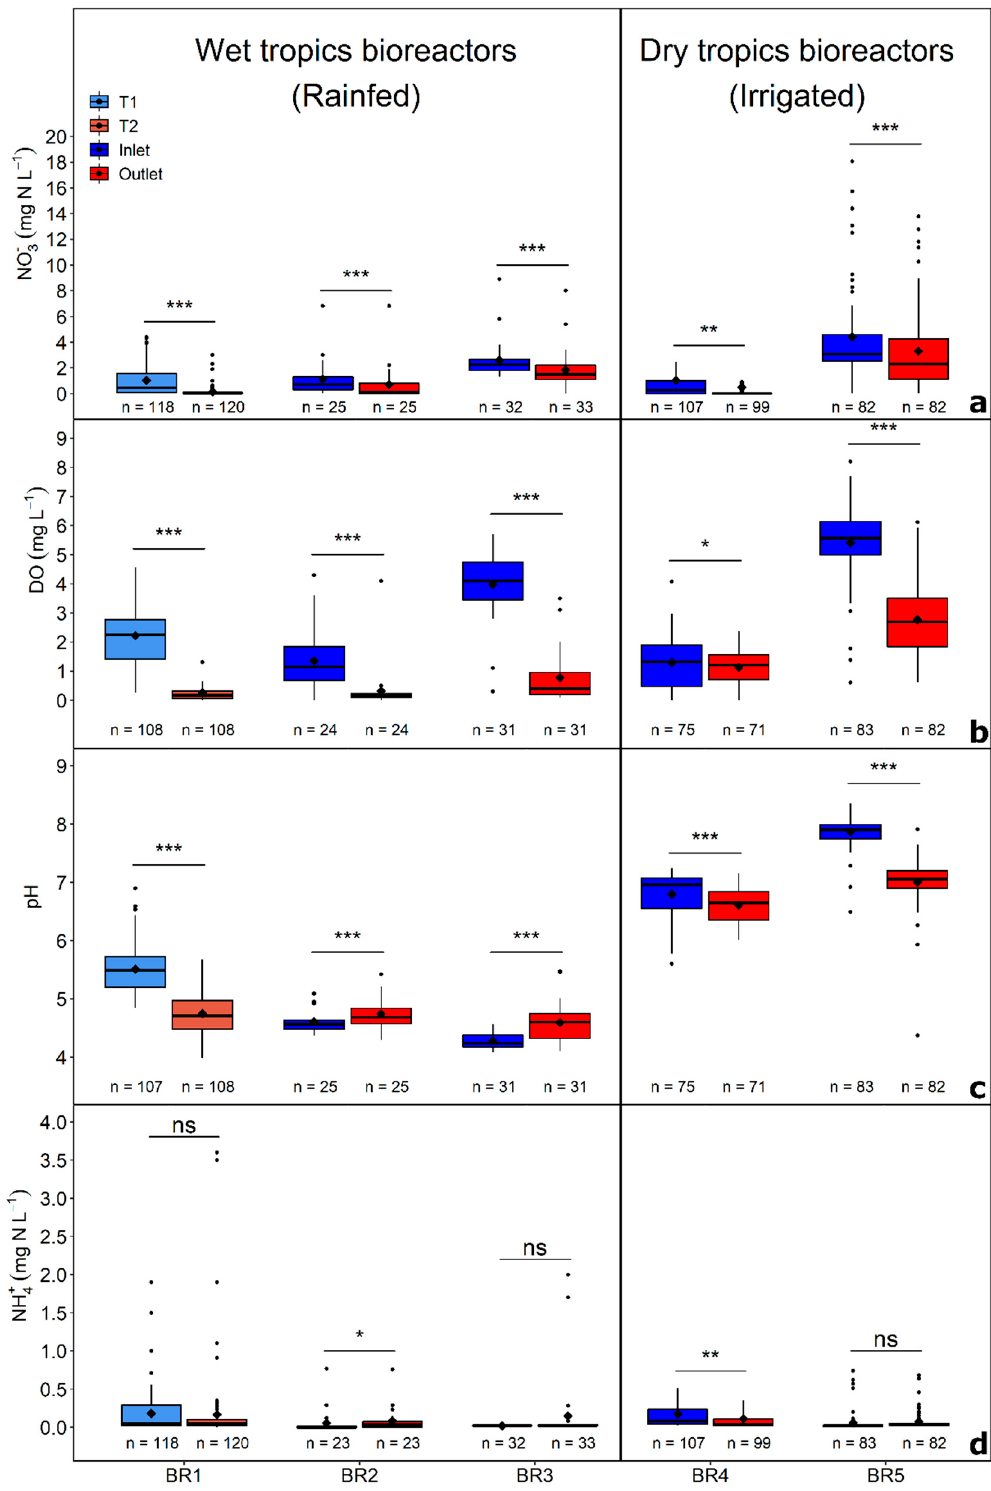
Figure 2. Boxplots of the NO 3 − concentration ( a ), dissolved oxygen (DO) ( b ) pH ( c ), and NH 4+ ( d ) measured in the up-gradient (T1) and wall (T2) transects of the wall BR1, and influent and effluent measured in the beds BR2–BR5. The solid line is the median, the black diamond is the mean, and black circles are the outliers. The sample count is displayed underneath each boxplot. The asterisks indicate statistical significance assessed with the linear mixed model (***: p < 0.001; **: p < 0.01; *: p < 0.05; ns: not significant).